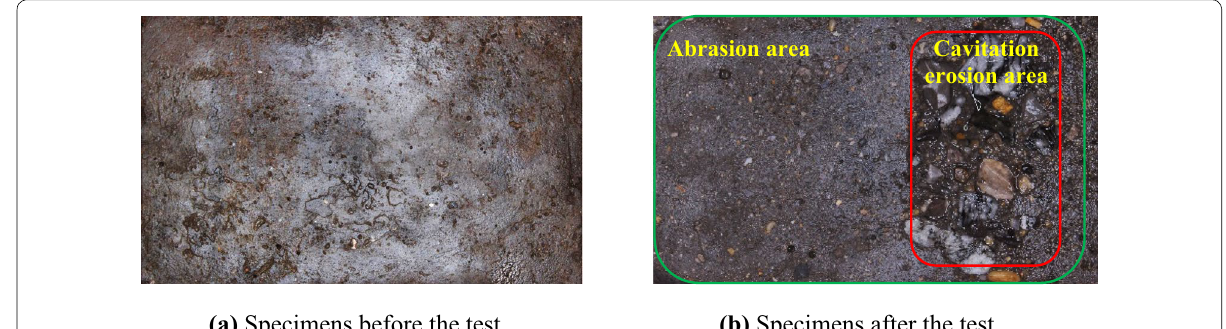
Fig. 9 Surface feature comparison before and after test (test time: 3 h).